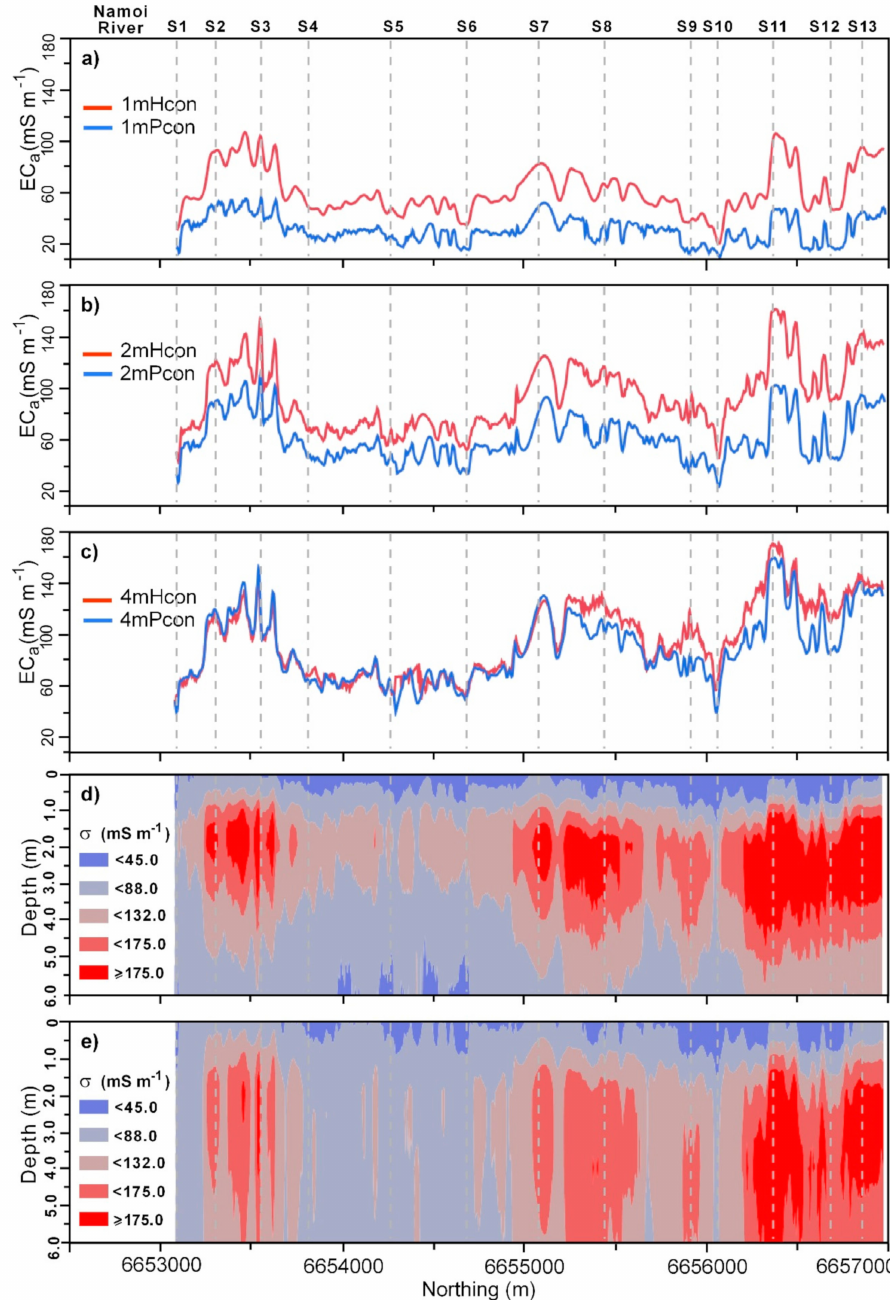
Figure 2. Measured the soil apparent electrical conductivity (EC a —mS m − 1 ) from DUALEM-421 in the horizontal (Hcon) and perpendicular (Pcon) coplanar arrays, including ( a ) 1mHcon and 1mPcon, ( b ) 2mHcon and 2mPcon and ( c ) 4mHcon and 4mPcon with electromagnetic conductivity images (EMCI) of estimates of the true electrical conductivity ( σ —mS m − 1 ) considering the inversion of all DUALEM-421 EC a and using the cumulative function forward model (CF), S2 inversion algorithm and λ = ( d ) 0.3 and ( e )